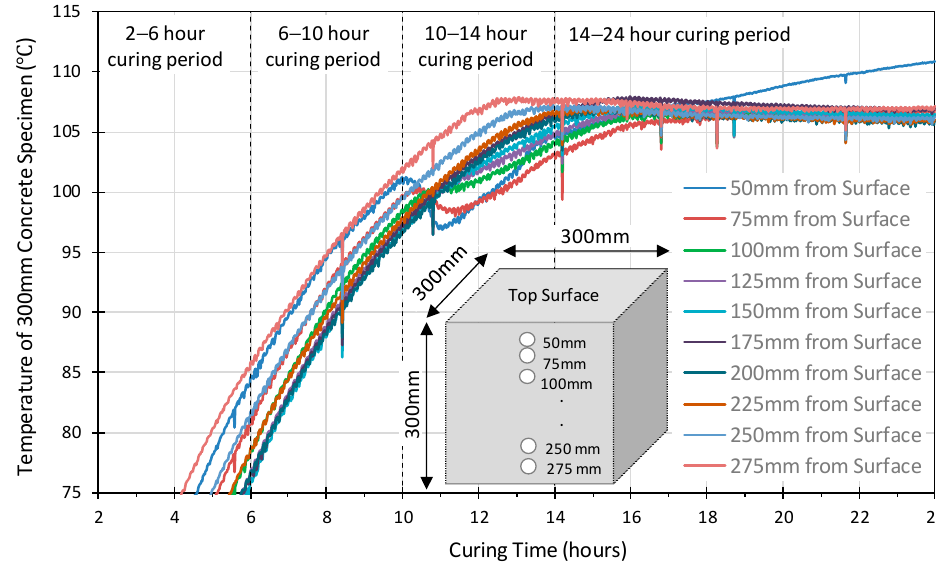
Figure 5. The temperature development versus the depth of 300 mm geopolymer concrete cube.